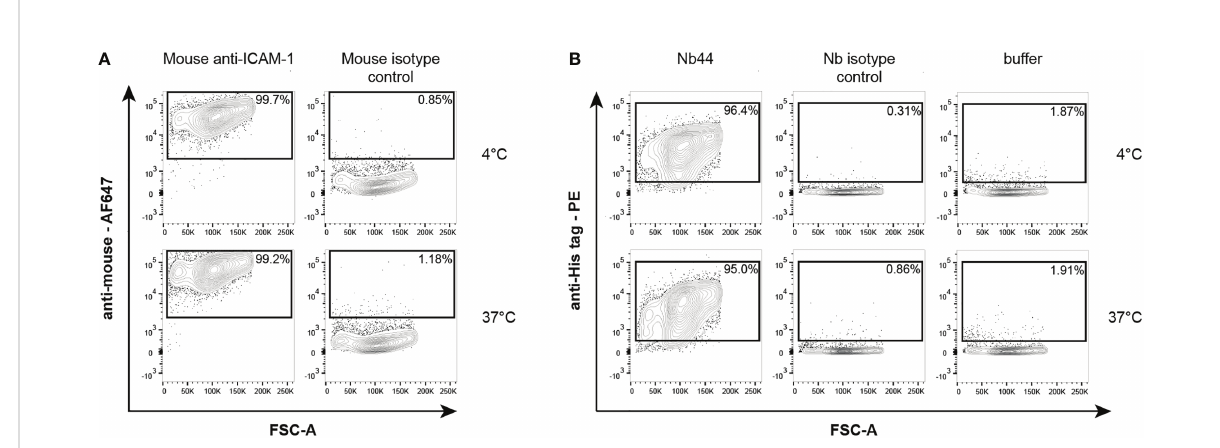
FIGURE 4 Flow cytometric analysis of mouse anti-ICAM-1 antibody (A) and Nb44 (B) binding to ICAM-1 expressed on 16HBE14o- cells. (A) Cells were incubated with a purchased mouse anti-ICAM-1 antibody or a mouse isotype control at 4°C (upper panels) or 37°C (lower panels), and subsequently stained with Alexa Fluor 467-conjugated anti-mouse antibody. Plots show forward scatter (FSC-A) (x-axes) versus anti-mouse Alexa Fluor 467 (y-axes). (B) Cells were incubated with Nb44 (left column), an isotype control (Bet v 1-speci fi c Nb, middle column) or buffer alone (right column) at 4°C (upper panels) or 37°C (lower panels). Plots show forward scatter (FSC-A) (x-axes) versus PE-labeled anti-His tag antibody (y-axes). 16HBE14o- cells (A, B) were previously selected for alive cells by negative staining with eFluor ® 780 viability dye. Experiments shown in (A, B) were performed in triplicates and representative plots of three independent experiments are